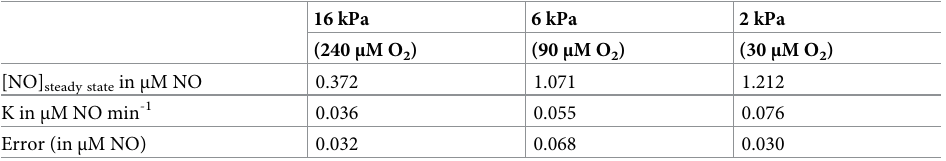
Table 3. Calculated rate constant (K) and steady state of NO ([NO] steady state ) in cell- and tissue-free respiration medium containing 197 μ M spermineNONOate at three different pO 2